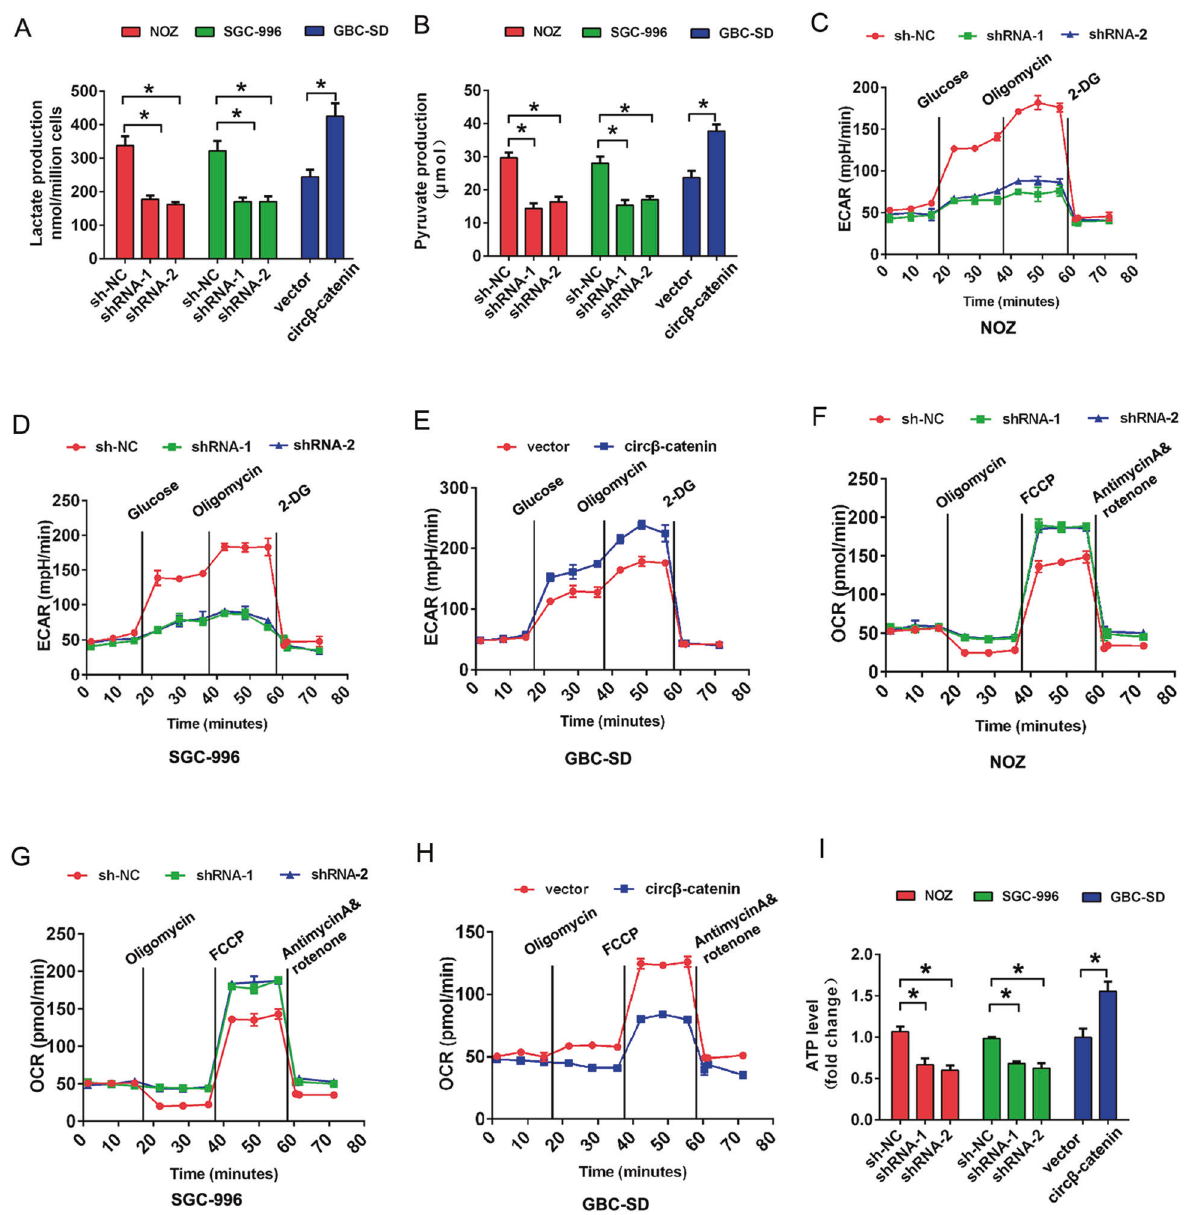
Fig. 4 The circ β -catenin promotes cell glycolysis in GBC cells. A , B The lactate production and pyruvate production levels were analyzed after transfection of NOZ and SGC-996 cells with shRNA-NC, shRNA-1, or shRNA-2, or after transfection of GBC-SD cells with pLCDH-vector or pLCDH-circ β -catenin in GBC-SD cells. C – E The extracellular acidi fi cation rate (ECAR) analysis for mitochondrial respiratory capacity was conducted using a Seahorse XFp assay after transfection of NOZ and SGC-996 cells with shRNA-NC, shRNA-1, or shRNA-2, or transfection of GBC-SD cells with pLCDH-vector or pLCDH-circ β -catenin. F – H The Oxygen consumption rate (OCR) analysis for mitochondrial respiratory capacity was conducted using a Seahorse XFp assay after transfection of NOZ and SGC-996 cells with shRNA-NC, shRNA-1, or shRNA-2, or after transfection of GBC-SD cells with pLCDH-vector or pLCDH-circ β -catenin. I ATP quantity analysis revealed the ATP quantity after transfection of NOZ and SGC-996 cells with shRNA-NC, shRNA-1, or shRNA-2, or after transfection of GBC-SD cells with pLCDH-vector or pLCDH-circ β -catenin. Data are shown as mean ± SD. * P <